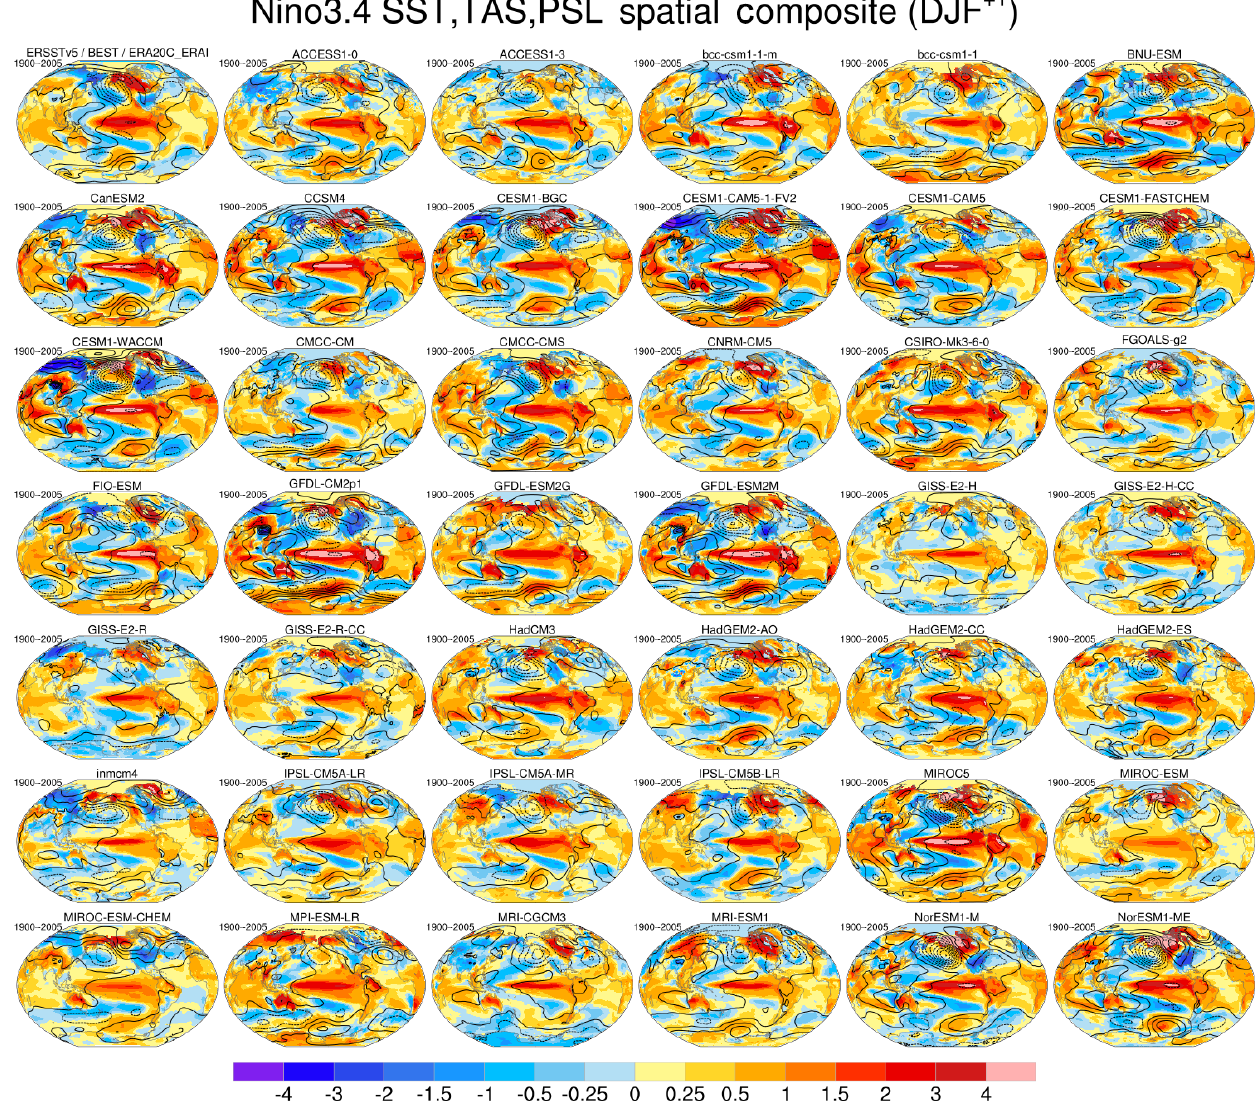
Figure 13. Global ENSO teleconnections during the peak phase (December–February) as simulated by 41 CMIP5 models (individual panels labelled by model name) and observations (first row, upper left panel) for the historical period (1900–2005 for models and 1920–2017 for observations). These patterns are based on composite differences between all El Niño events and all La Niña events (using a ± 1 standard deviation threshold of the Niño 3.4 SST Index) occurring in the period of record. Colour shading denotes SST and terrestrial TREFHT (surface air temperature at reference height) ( ◦ C), and contours denote sea level pressure (psl); contour interval of 2hPa, with negative values dashed). The period of record is given in the upper left of each panel. Observational composites use ERSSTv5 for SST, BEST for tas (near-surface air temperature), and ERA20C updated with ERA-I for psl. Figure produced with recipe_CVDP.yml. ; see details in Sect.